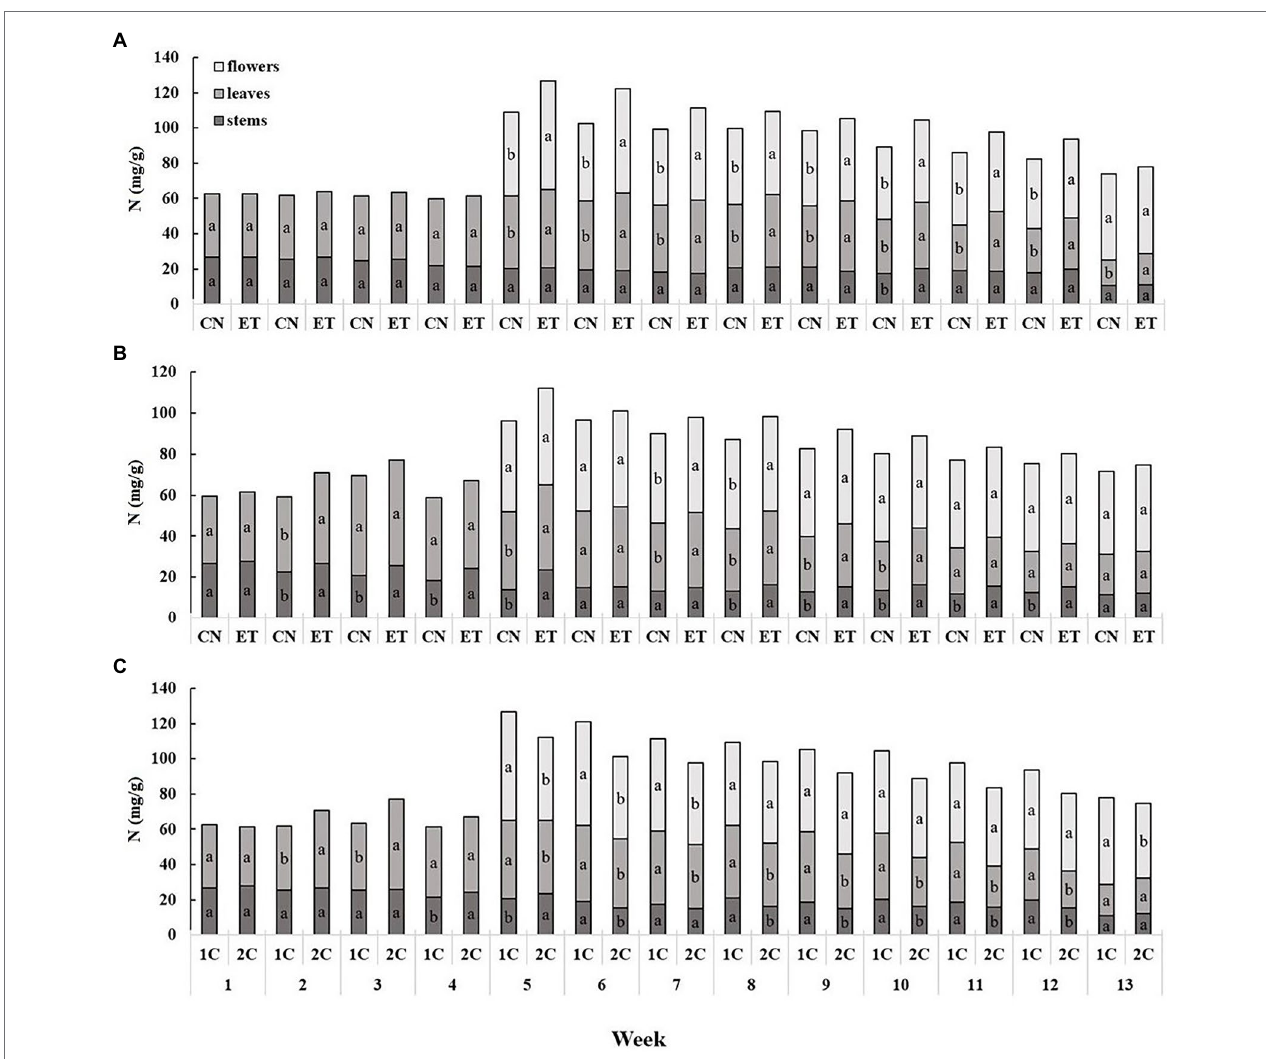
FIGURE 2 | Distribution of nitrogen among the organs of medical cannabis plants as affected by amino acid (AA) supplementation and nutrient cycle. N concentration of control (CN) and enhanced treatment (ET) with AAs nutritional supplement in recirculation (1C) growing cycle (A) , in drain-to-waste (2C) growing cycle (B) , ETs in 1C and 2C (C) in stems, leaves, and flowers. Data are means ± SE ( n = 3). The different small letters inside the bars represent significant differences within the plant organs (stems, leaves, and flowers) between the variants in a particular week according to Tukey’s HSD test at α =